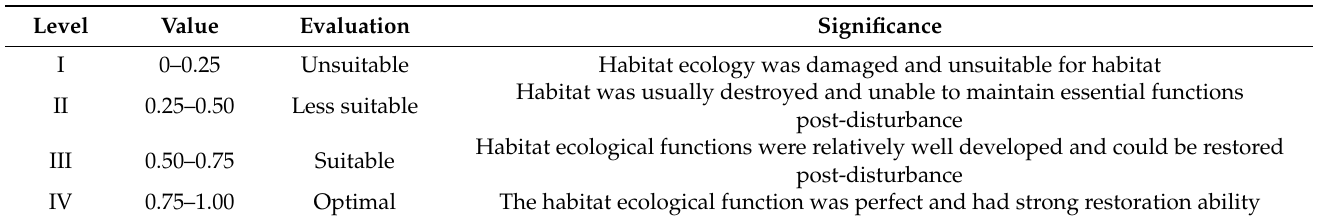
Table 1. Habitat suitability index classification